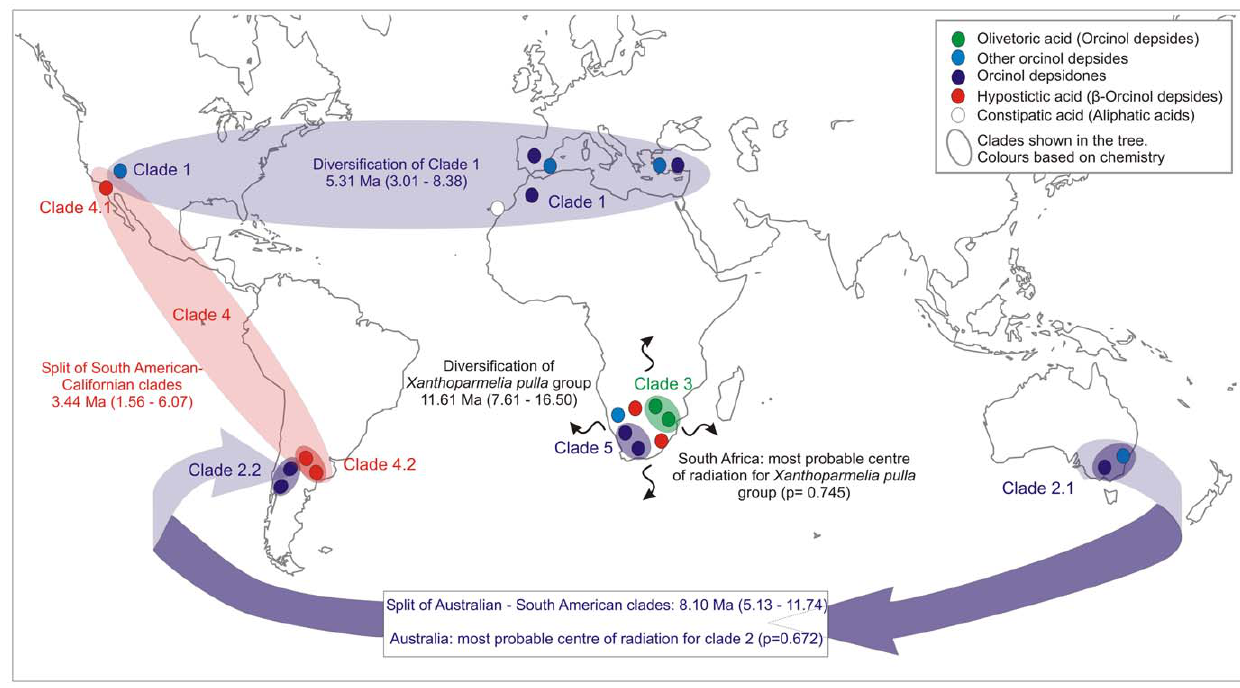
Figure 2. Schematic map showing the relationships between phylogeny, medullary compounds, ancestral range and divergence times estimation for the Xanthoparmeliapulla group.